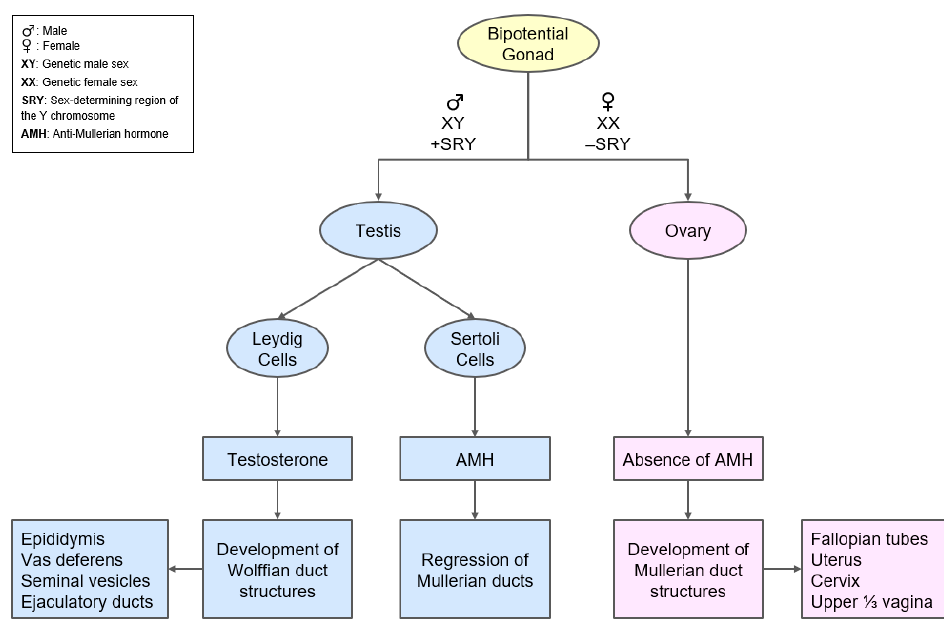
Figure 2. Schematic representation of the role of AMH in the sexual differentiation of the